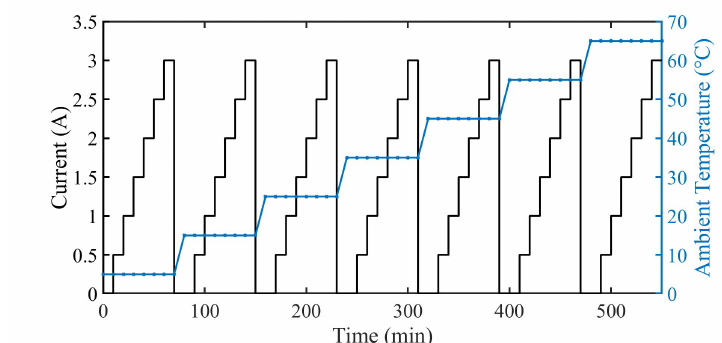
Figure 3. The current (A) and ambient temperature ( ◦ C) profile used as the input for the experimental validation setup that is shown in Figure